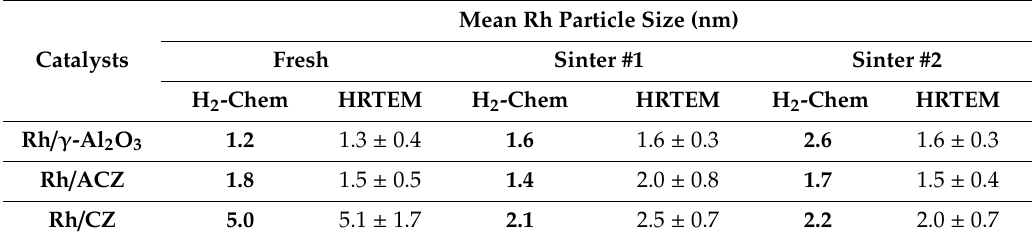
Table 2. Sintering characteristics of the fresh Rh catalysts exposed to oxidative thermal aging.